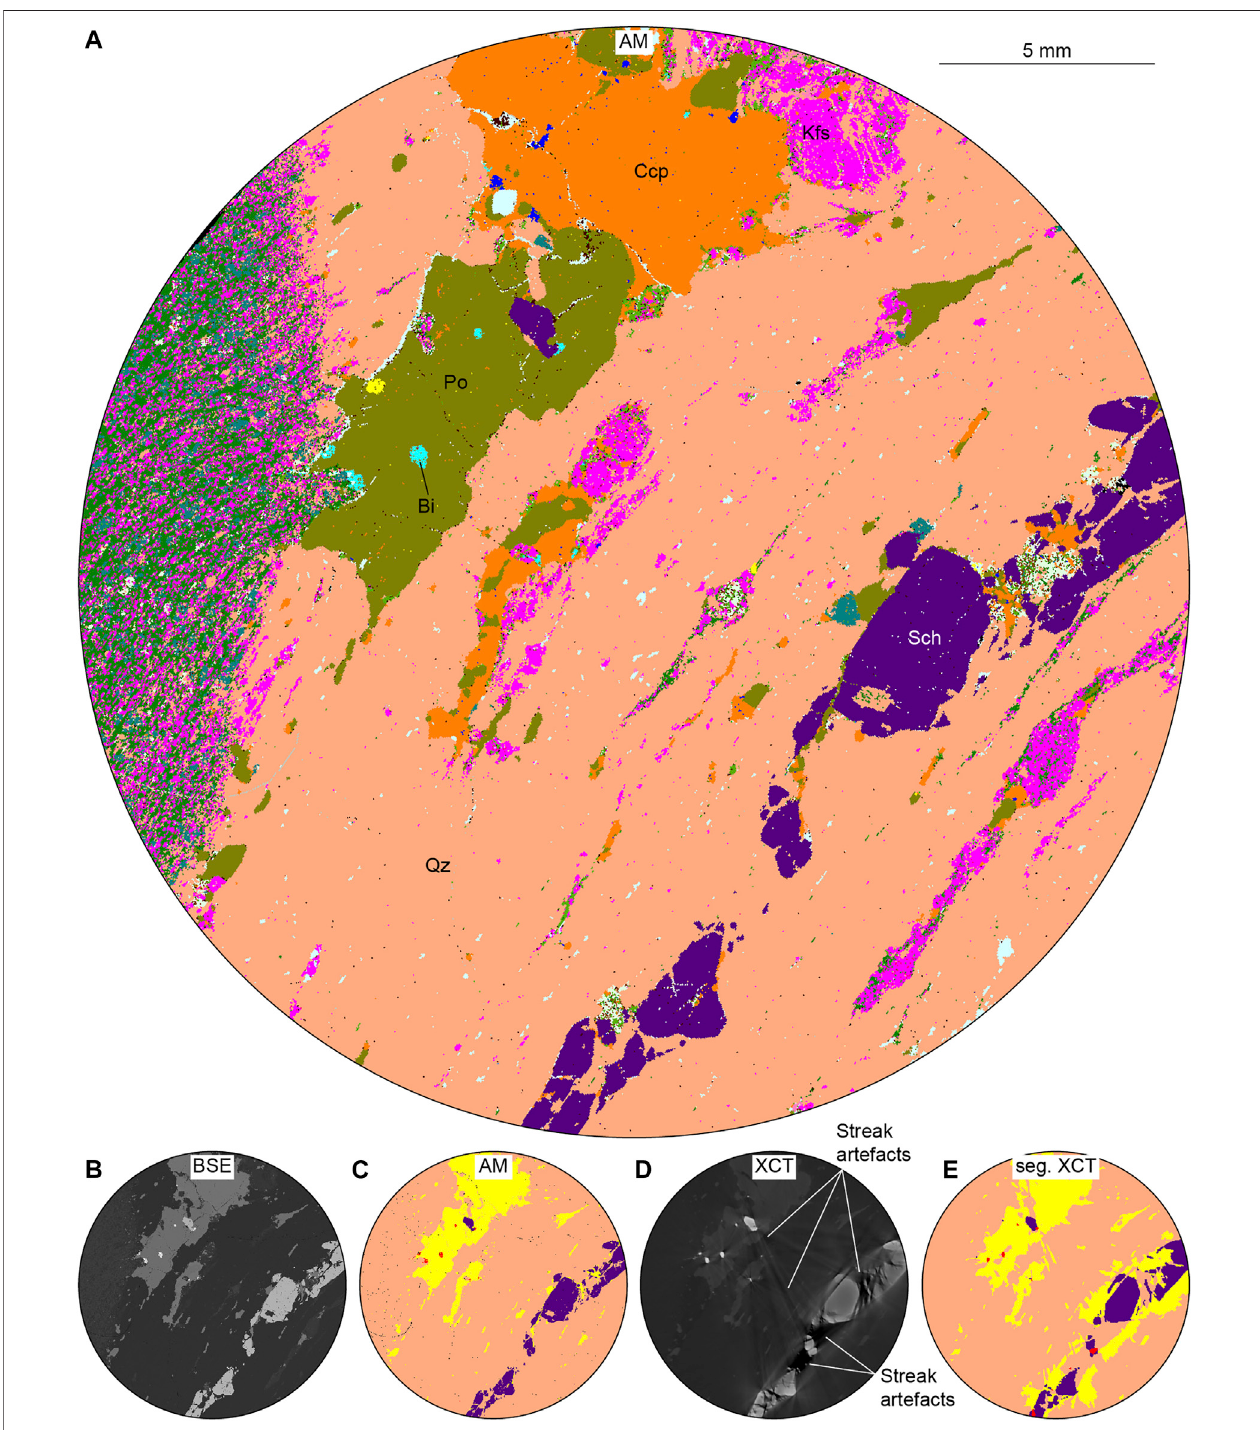
FIGURE 2 | AM and XCT images of a polished rock chip of a scheelite- and Bi-telluride-bearing aplite (sample 1). For color coding of the minerals see Table 2 . (A) 30 μ mpixelsizeAMmineralmap. (B) 1.87 μ mpixelsizeAMBSEimage. (C) 30 μ mpixelsizesimpli fi edAMmineralmap. (D) 30 μ mvoxelsizeXCTscan. (E) 30 μ mvoxel size segmented XCT scan. Streak artefacts of scheelite and Bi-mineral grains in the XCT scan (D) cause segmentation of scheelite grain boundaries as heavy minerals, quartz as sul fi des (bright streaks), and sul fi des as quartz (dark streaks). Abbreviations: Ccp – chalcopyrite, Kfs – k-feldspar, Po – pyrrhotite, Sch – scheelite, Qz – quartz.